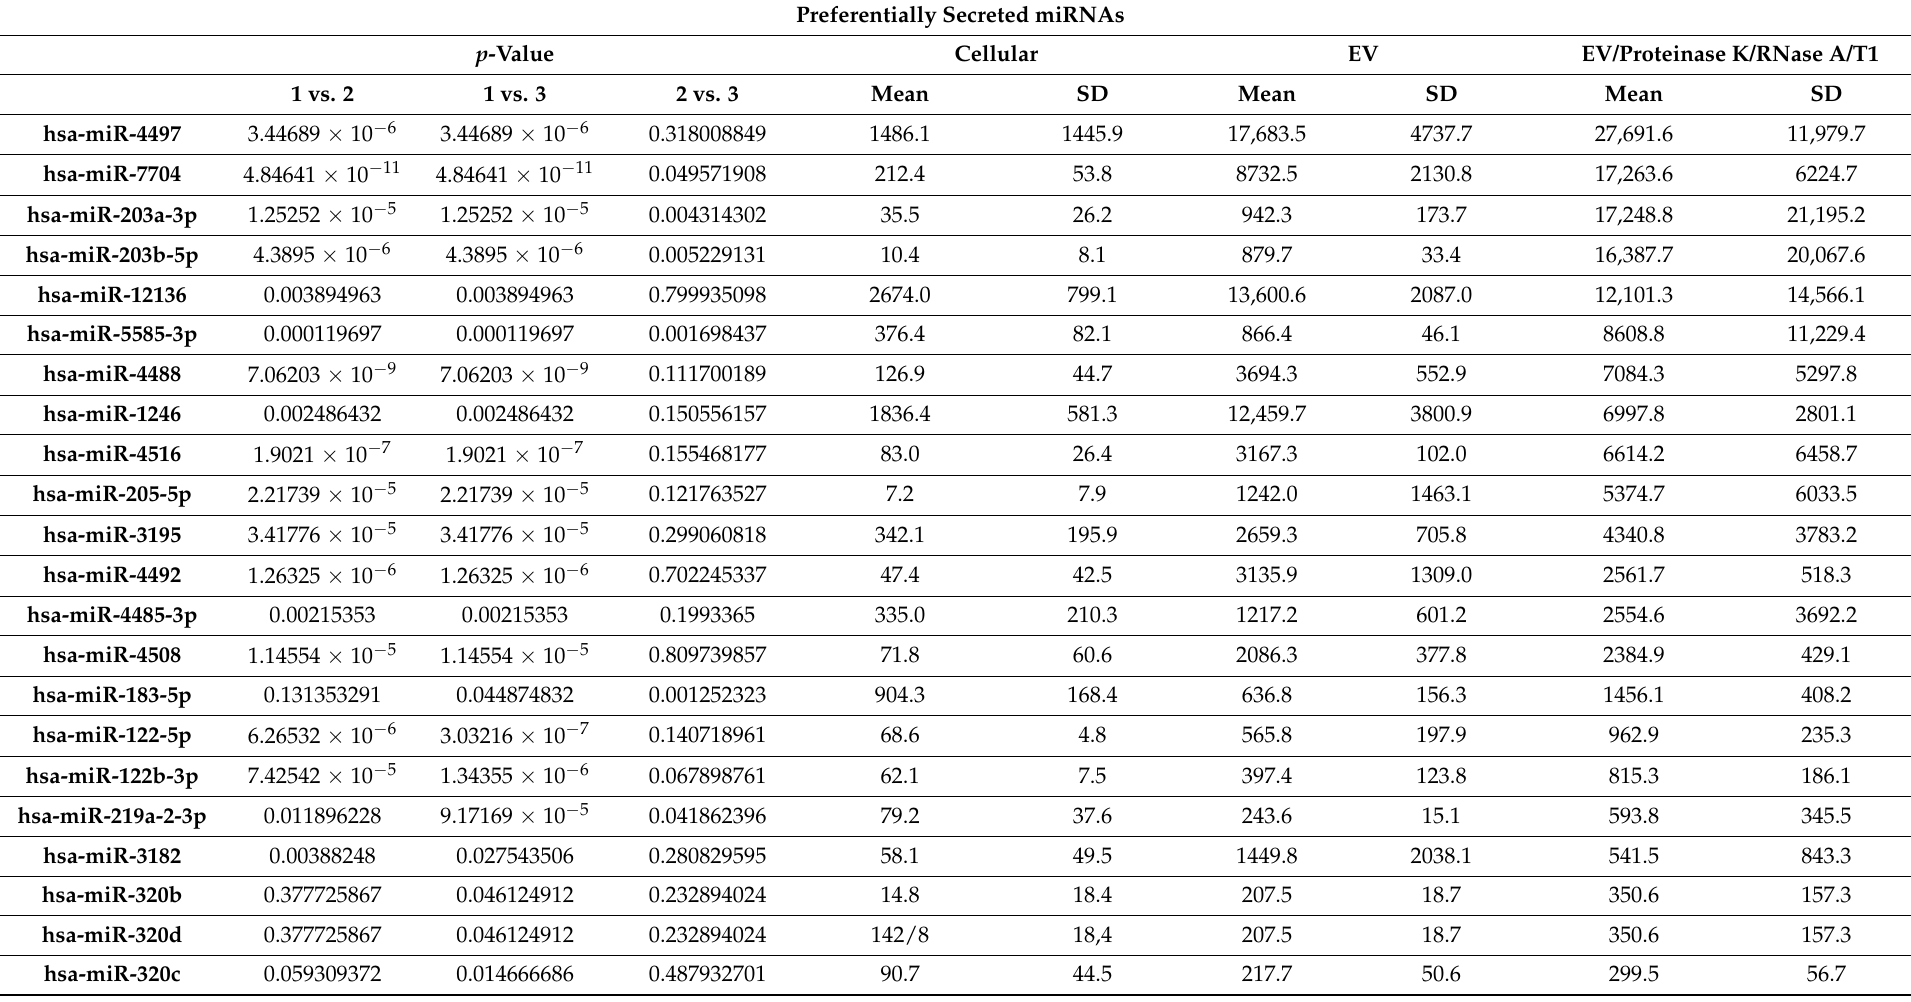
Table 1. Preferentially secreted miRNAs and the p -values comparison for each group (1 = cellular, 2 = EV-enriched, and 3 = EV lumen), shown as the mean and SD of three separate biological